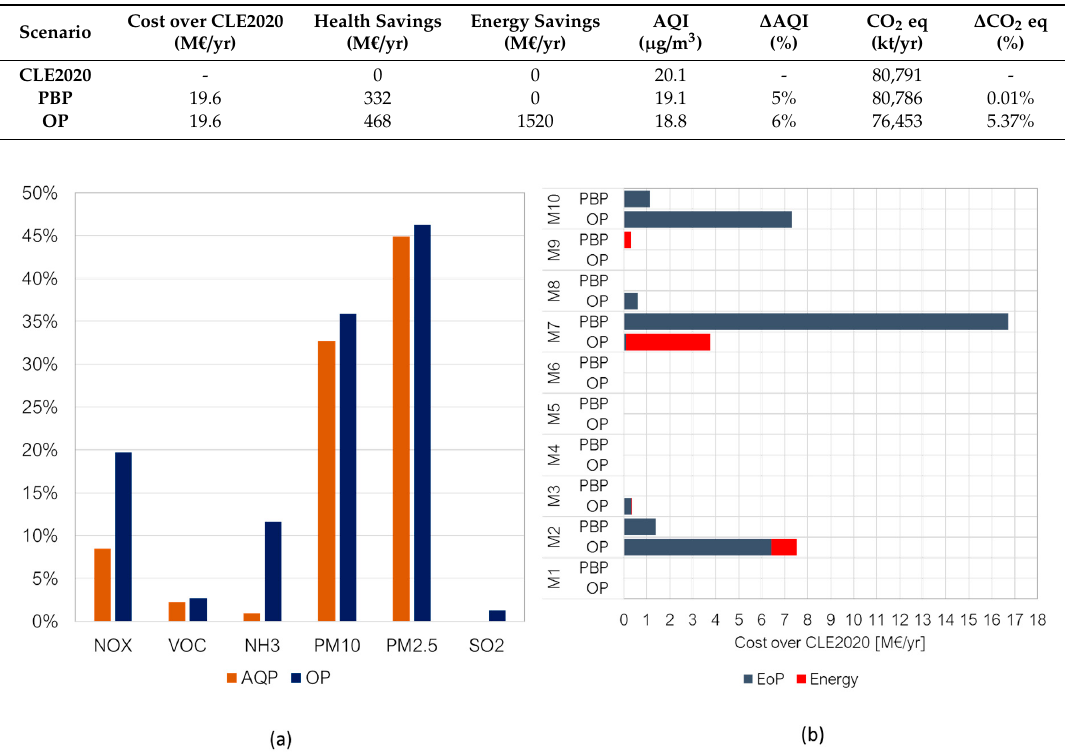
Figure 7. ( a ) Percentage pollutant emission reduction computed by the MAQ system for the two scenarios, PBP and OP. ( b ) Cost over CLE2020 in each CORINAIR SNAP1 macrosectors for the two scenarios analyzed. Table 4. Main measures, both end ‐ of ‐ pipe and energy measures (in italics), selected through the cost ‐ effectiveness optimization approach.